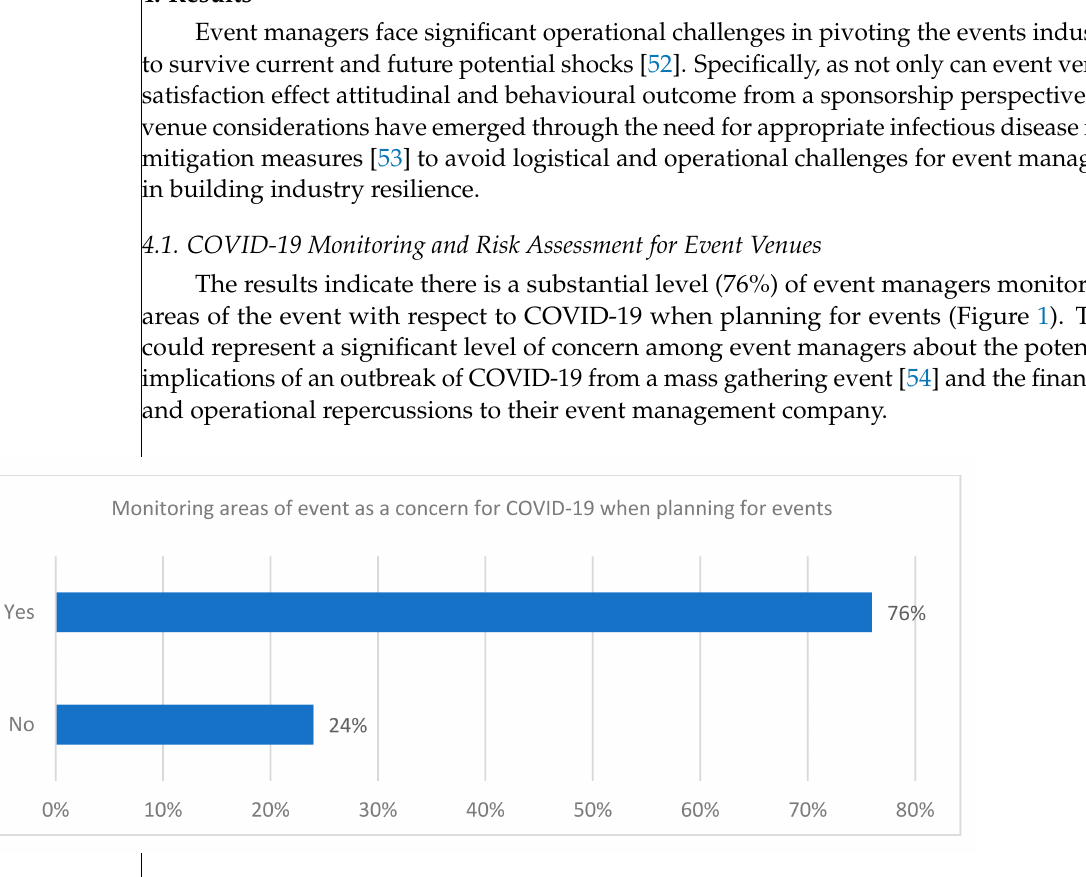
Figure 1. Event managers monitoring areas of events that may be a cause for concern with respect to COVID-19 when planning for events ( n =